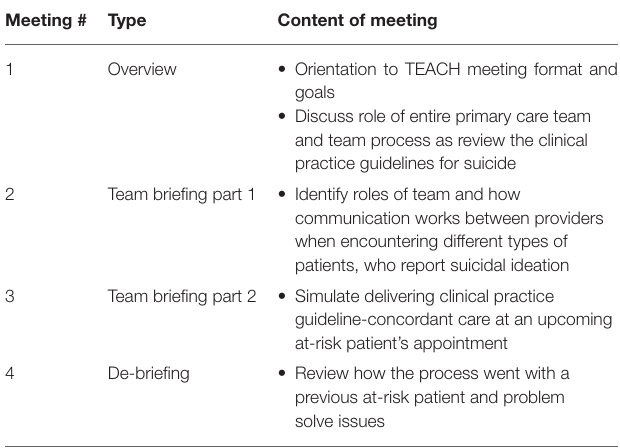
TABLE 1 | Goals of four meetings in the TEACH